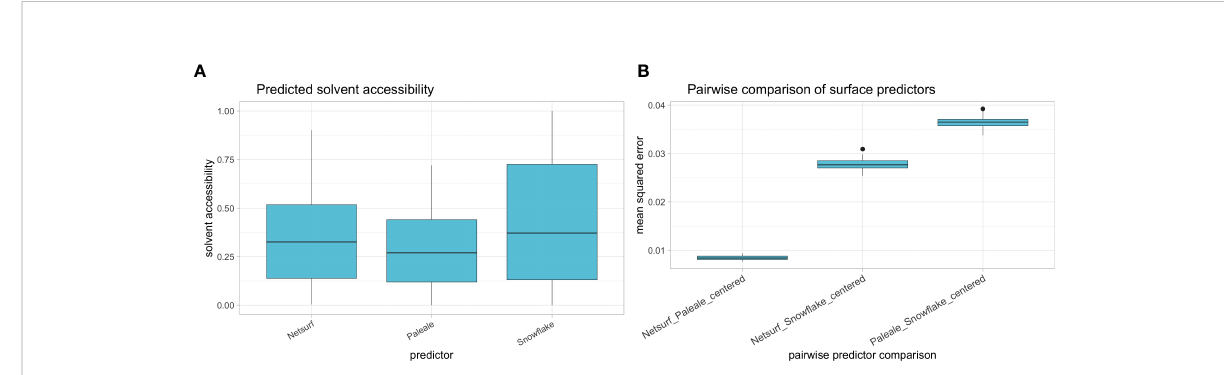
FIGURE 7 (A) Solvent accessibility distribution of reference alleles as predicted by NetSurfP (i.e. “ rsa ” ), PaleAle (i.e. Relative Solvent Accessibility) and Snow fl ake. (B) Pairwise mean squared distance between centered predictions of NetSurfP and PaleAle, NetSurfP and Snow fl ake, and PaleAle and Snow fl ake. Boxplots depict the median (horizontal line), fi rst to third quartile (box); the highest and lowest values within 1.5× IQR (whiskers) and outliers (circles),